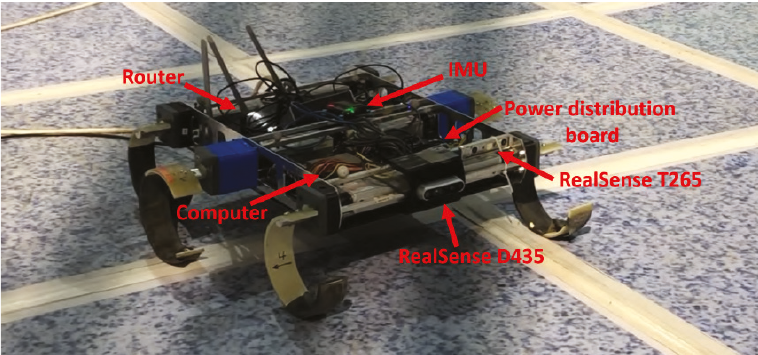
Figure 17. Components installed on the CLHeRo for the tests.